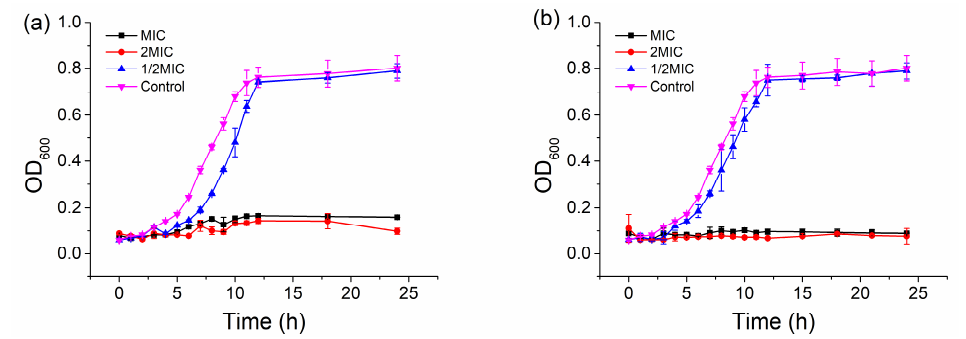
Figure 6. Growth curves of E. coli in the presence of (a) CBDVA and (b) CBDA at different concen- trations.